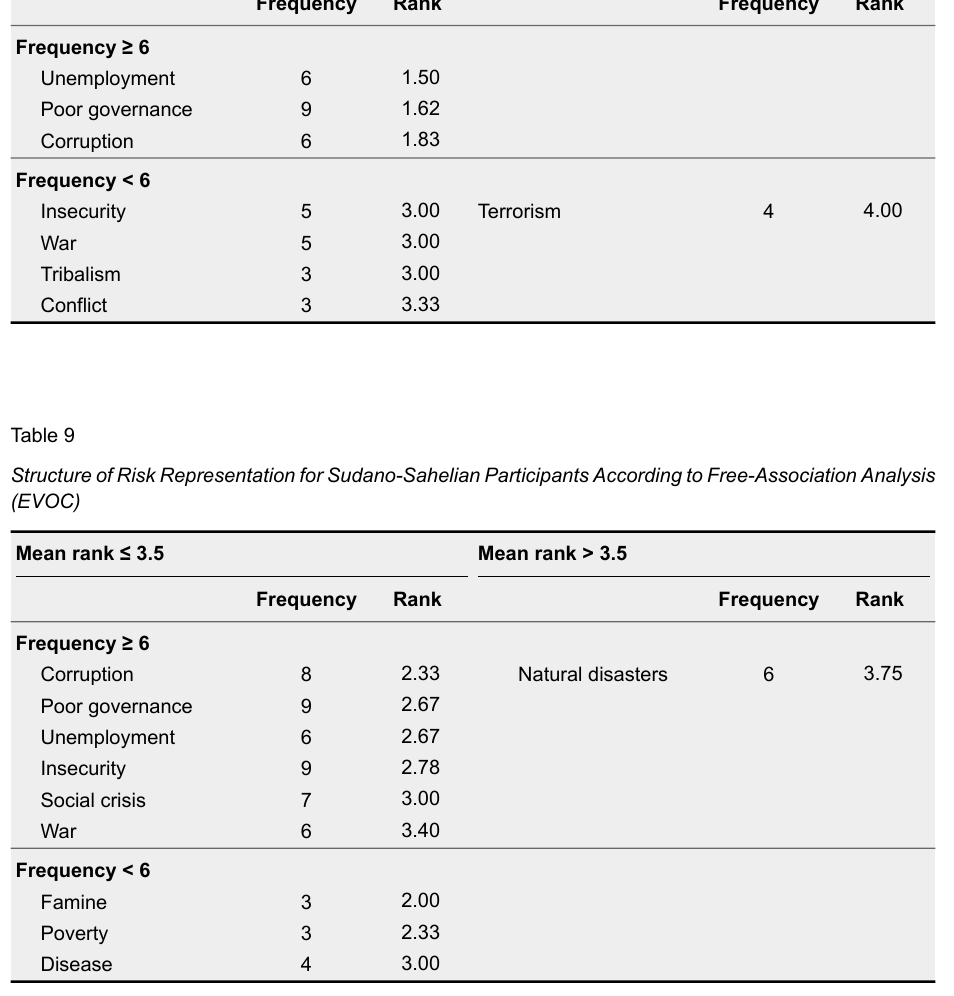
Mean rank > 3.5Mean rank ≤ 3.5